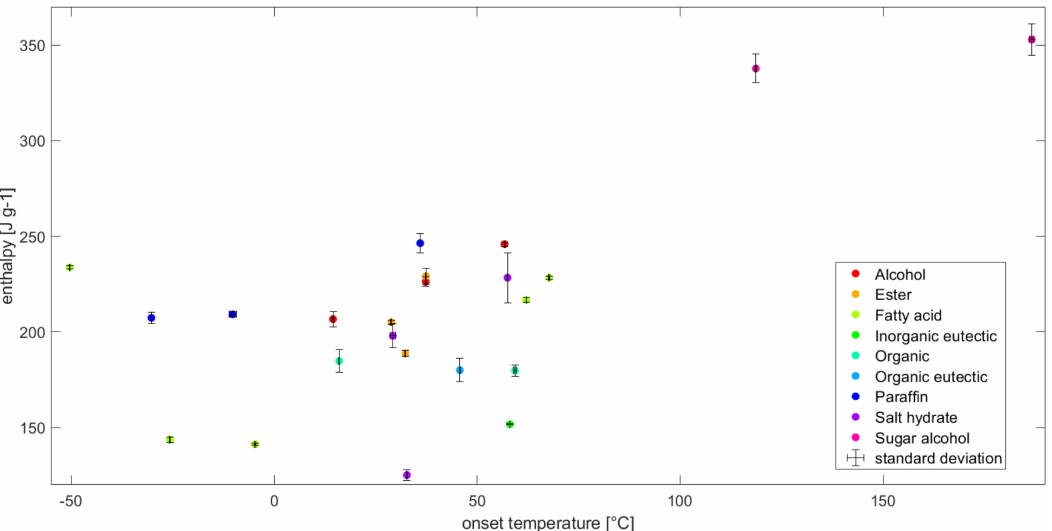
Figure 12. Enthalpy over onset temperature of materials, as given in Table 5. Additionally, the standard deviation is indicated by error bars showing their narrow distribution around the